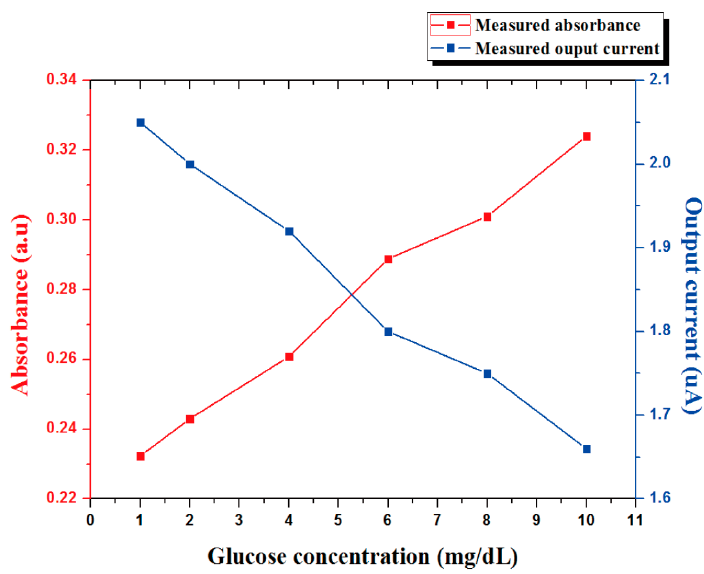
Figure 12. Measured absorbance as a function of the concentration of glucose at a wavelength of 630 nm.